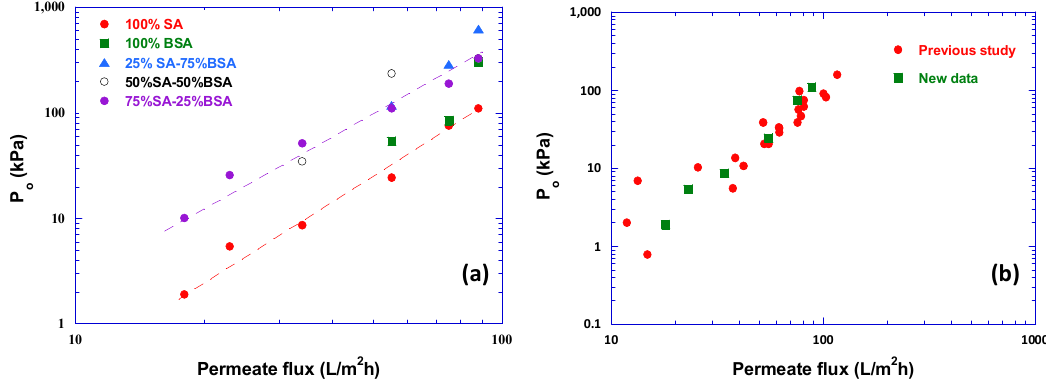
Figure 7. Values of parameter P o (Equation (8)) versus permeate flux J. ( a ) Data from this study; ( b ) comparison of P o data, for 100% SA, from this study with data from previous work [ 31 ].